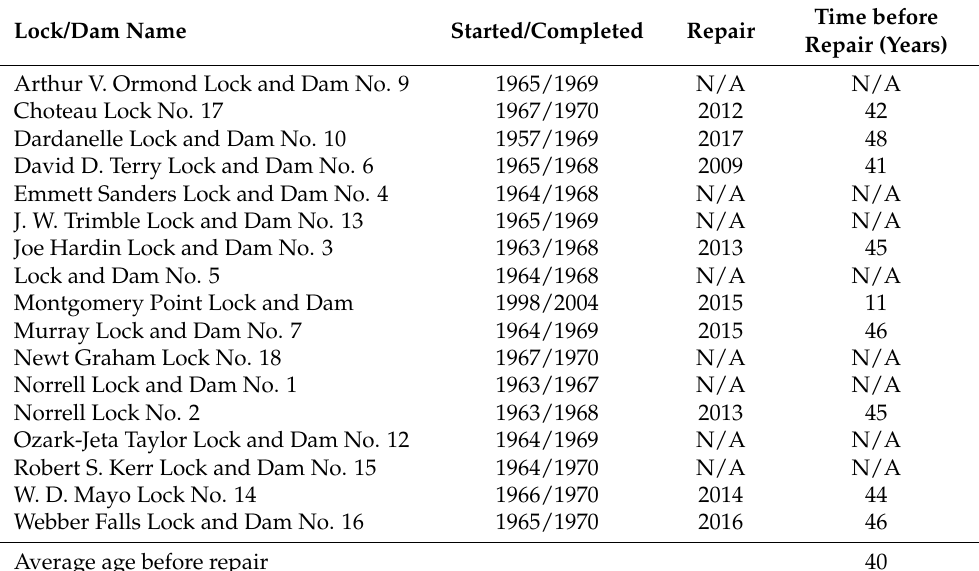
Figure 1. Function of lock gates within the lock system. ( a ) The lower gate is lowered, allowing for entrance to the lock. ( b ) The lower gate closes and the water level changes. ( c ) The upper gate opens, allowing the vessel access to the higher water elevation. Table 1. List of gates on the Arkansas River system, completed date, and date of repair.